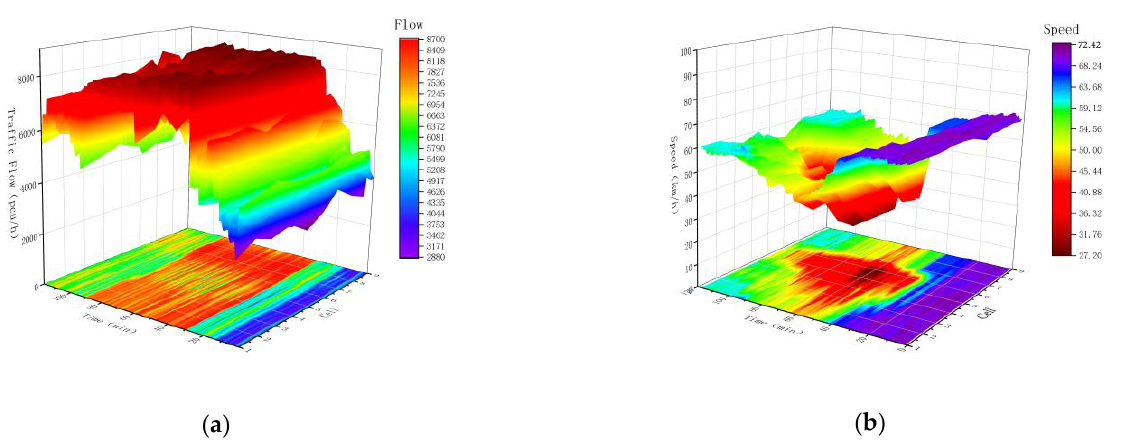
Figure 14. Simulation results. ( a ) Traffic flow output; ( b ) Traffic flow speed output.